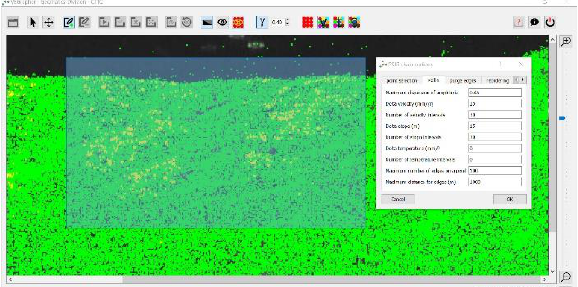
Figure 4: Local reprocessing - selecting the critical area and setting the control parameters.